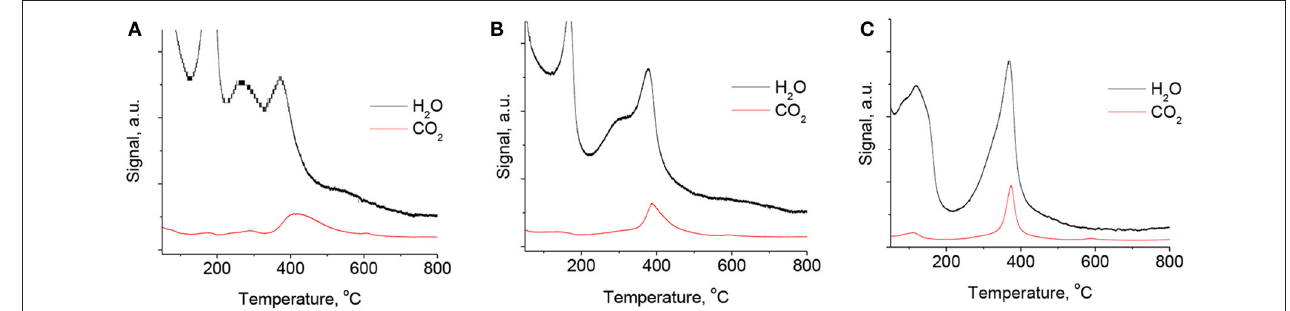
FIGURE 4 | TGA-MS spectra of evolved H 2 O and CO 2 molecules for MgGa-2A (A) , MgGa-3A (B) , and MgGa-4A (C) samples.